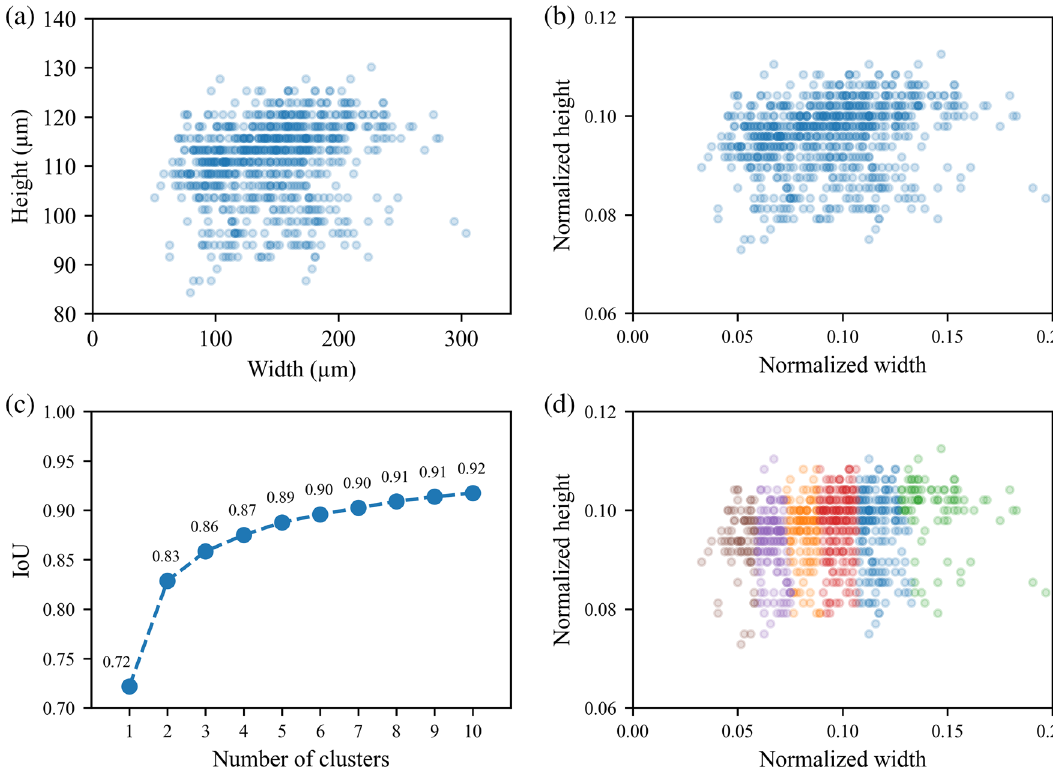
Figure 9. K-means clustering for YOLOv3 anchor boxes: widths and heights of ground truth bounding boxes ( a ) in µm and ( b ) normalized to the image size; ( c ) IoU for different numbers of clusters; ( d ) k-means clustered data set into six clusters.